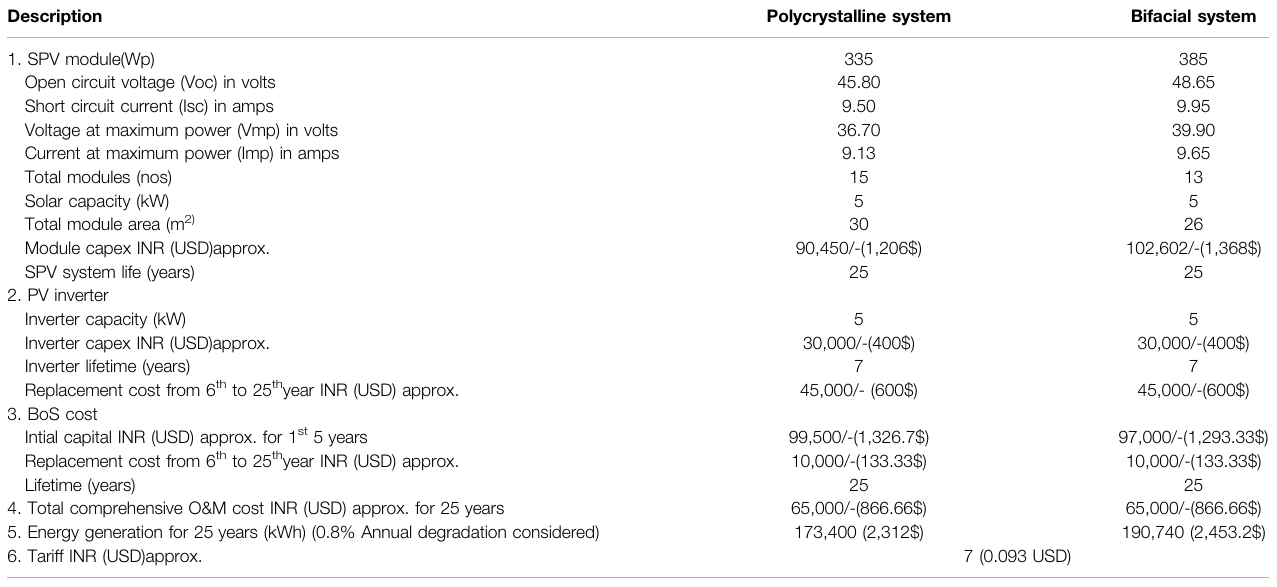
TABLE 1 | Component costs (All in INR and USD).